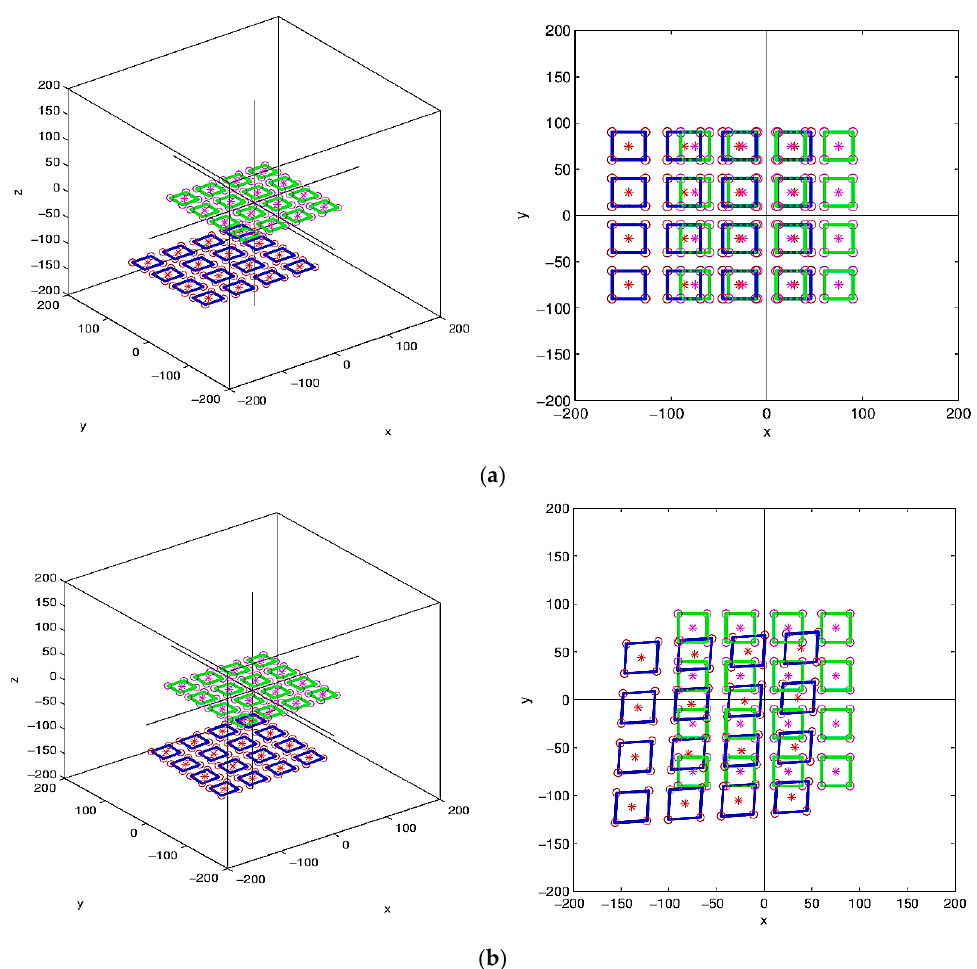
Figure 19. MATLAB calculation predicts array rectangular microstructure (4 × 4). ( a ) Rotation angle 0°, tilt angle π /6°; ( b ) rotation angle π /6°, tilt angle π /6°.